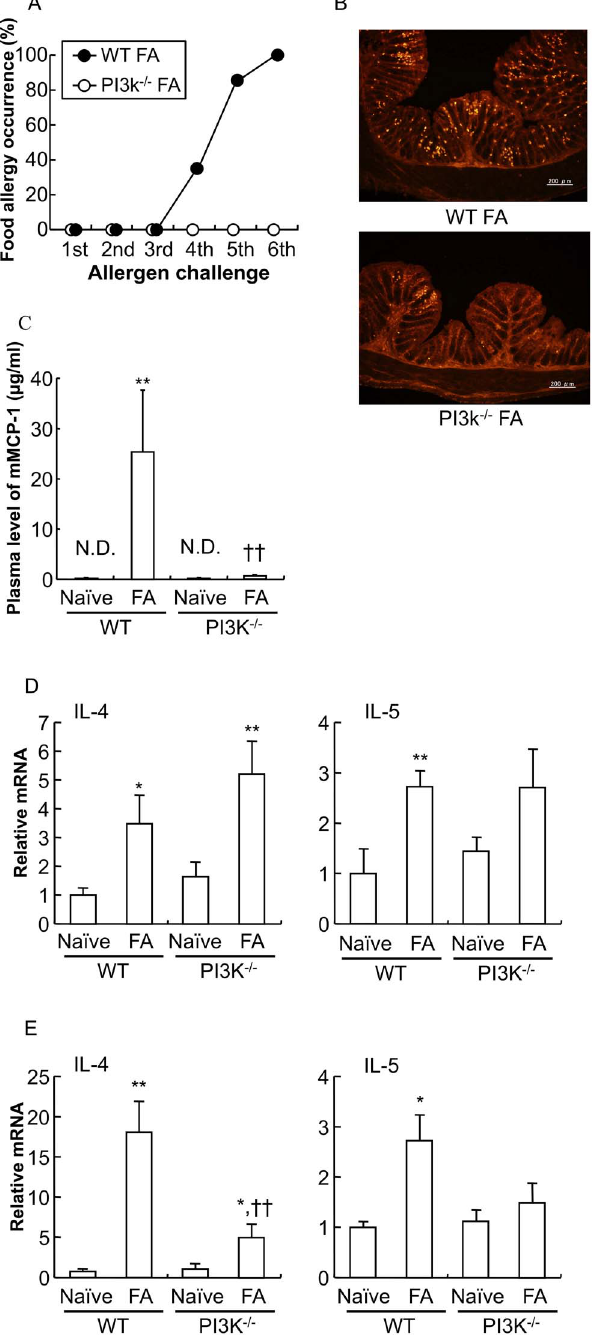
Figure 6. Induction of food allergy in PI3K-deficient mice. PI3K 2 / 2 mice as a gastrointestinal mast cell-deficient murine model were subjected to FA-inducing oral OVA challenges. A : The occurrence of allergic diarrhea in WT mice (WT FA mice) and PI3K 2 / 2 mice (PI3K 2 / 2 FA mice) after each oral OVA challenge is shown ( n =5 mice per group). B : The proximal colon of FA-induced PI3K 2 / 2 mice after oral OVA challenge was stained with anti- mMCP-1 antibodies. Scale bars represent 200 m m. C : The level of mMCP-1 in the plasma of PI3K 2 / 2 naı¨ve mice and PI3K 2 / 2 FA mice is shown. The level of mMCP-1 in the plasma was determined using an ELISA kit. Data are expressed as means 6 SE. ** P , 0.01 vs. WT naı¨ve mice, {{ P , 0.01 vs. WT FA mice ( n =3–5 mice per group). IL-4 and IL-5 cytokine mRNA expression in the spleen ( D ) and proximal colon ( E ) from WT naı¨ve mice, WT FA mice, PI3K 2 /